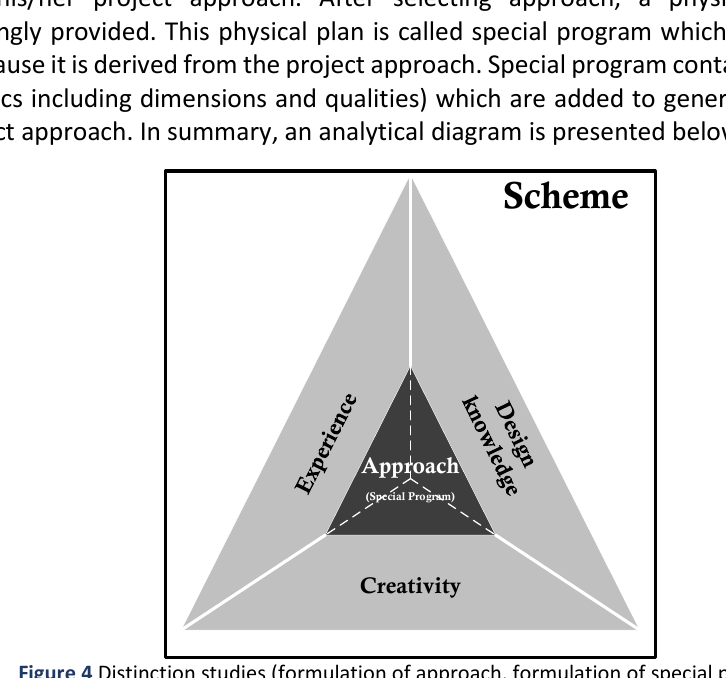
Figure 4 Distinction studies (formulation of approach, formulation of special